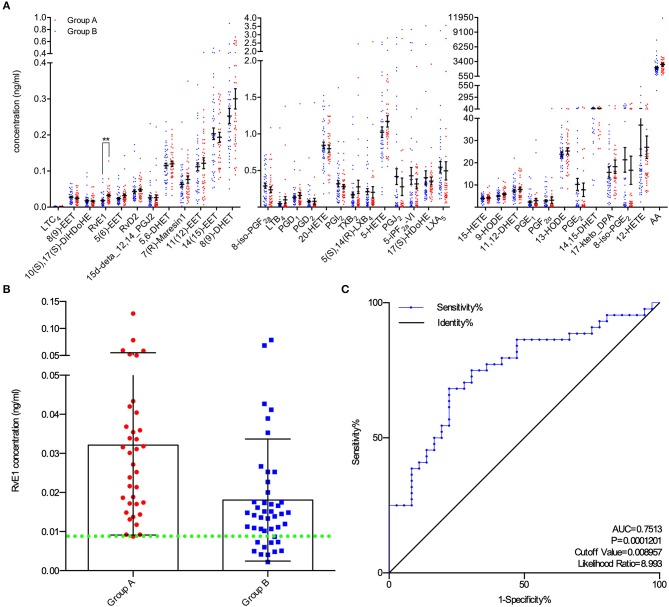
Higher level of RvE1 in follicular fluid (FF) related to oocytes which were able to form blastocysts of high quality. (A) Liquid chromatography electrospray ionization tandem mass spectrometry (LC/ESI-MS/MS) was applied to quantitatively analyze metabolite profiles in the FF of oocytes which were able (N = 36) or unable (N = 44) to form high-quality blastocysts. Data are presented as mean ± SEM; **p = 0.0018, t-test with two tails, independent biological replicates number as shown after N. LTC4, Leukotriene C4; 8(9)-EET, 8,9-epoxyeicosatrienoic acid; 10(S),17(S)-DiHDoHE, 10(S),17(S)-dihydroxy-4Z,7Z,11E,13Z,15E,19Z-docosahexaenoic acid; RvE1, Resolvin E1, 5S,12R,18R-trihydroxy-6Z,8E,10E,14Z,16E-eicosapentaenoic acid; 5(6)-EET, 5,6-epoxy-8,11,14-eicosatrienoic acid; RvD2, Resolvin D2, (4Z,7R,8E,10Z,12E,14E,17S,19Z)-7,16,17-trihydroxy-4,8,10,12,14, 19-docosahexaenoic acid; 15d-deta_12,14_PGJ2, 15-deoxy-Δ12,14-Prostaglandin J2, 15-deoxyprostaglandin J2; 5,6-DHET, 5,6-dihydroxy-8Z,11Z,14Z-eicosatrienoic acid; 7(R)-Maresin1, 7R,14S-dihydroxy-4Z,8E,10E,12Z,16Z,19Z-docosahexaenoic acid; 11(12)-EET, 11, (12)-epoxy-5Z,8Z,14Z-eicosatrienoic acid; 14(15)-EET, 14, (15)-epoxy-5Z,8Z,11Z-eicosatrienoic acid; 8(9)-DHET, 8,9-dihydroxy-5Z,11Z,14Z-eicosatrienoic acid; 8-iso-PGF2a, 8-isoprostaglandin F2α, 9α,11α,15S-trihydroxy-(8β)-prosta-5Z,13E-dien-1-oic acid; LTB4, Leukotriene B4, 5S,12R-dihydroxy-6Z,8E,10E,14Z-eicosatetraenoic acid; PGD1, Prostaglandins D1, 9α,15S-dihydroxy-11-oxo-prost-13E-en-1-oic acid; PGD2, Prostaglandins D2, 9α,15S-dihydroxy-11-oxo-prosta-5Z,13E-dien-1-oic acid; 20-HETE, 20-hydroxy-5Z,8Z,11Z,14Z-eicosatetraenoic acid; PGI2, Prostaglandin I2, 6,9α-epoxy-11α,15S-dihydroxy-prosta-5Z,13E-dien-1-oic acid; TXB2, thromboxane B2 9α,11,15S-trihydroxythromba-5Z,13E-dien-1-oic acid; 5(S),14(R)-LXB4, 5(S),14(R)-lipoxin B4; 5-HETE, 5-hydroxy-6E,8Z,11Z,14Z-eicosatetraenoic acid; PGJ2, 11-oxo-15S-hydroxy-prosta-5Z,9,13E-trien-1-oic acid; 5-iPF2a-VI, 5-isoprostane F2alpha-VI, (8β)-5,9α,11α-trihydroxy-prosta-6E,14Z-dien-1-oic acid; 17(S)-HDoHE, 17S-hydroxy-4Z,7Z,10Z,13Z,15E,19Z-docosahexaenoic acid; LXA5, 5S,6R,15S-trihydroxy-7E,9E,11Z,13E,17Z-eicosapentaenoic acid; 15-HETE, 15-hydroxy-5,8,11,13-eicosatetraenoic acid; 9-HODE, 9-hydroxylinoleic acid, 9-hydroxy-10,12-octadecadienoic acid; 11,12-DHET, 11,12-dihydroxyeicosatrienoic acid; PGE1, Prostaglandin E1; PGF2α, Prostaglandin F2α; 13-HODE, 13-hydroxylinoleic acid, 13-hydroxy-10,12-octadecadienoic acid; PGE2, Prostaglandin E2; 14,15-DHET, 14,15-dihydroxyeicosatrienoic acid; 17-keto_DPA, 7Z,10Z,13Z,15E,19Z-17-oxo-docosapentaenoic acid; 8-iso-PGE2, 8-isoprostaglandin E2, 9-oxo-11α,15S-dihydroxy-(8β)-prosta-5Z,13E-dien-1-oic acid; 12-HETE, 12-Hydroxy-5,8,10,14-eicosatetraenoic Acid; AA, acids arachidonic acid. (B) All RvE1 values in FF of enrolled 80 patients were shown with cutoff value line (green dotted line). Data are presented as mean ± SD. Group A: blastocysts of high quality (blastocyst score ≥ B3BC and B3CB, N = 36); Group B: blastocysts of low quality (blastocyst score < B3BC and B3CB, N =44). (C) Receiver operating characteristic (ROC) curve analysis was used to determine the predictive power and cutoff value of RvE1 in FF of oocytes able or unable to form high-quality blastocysts.